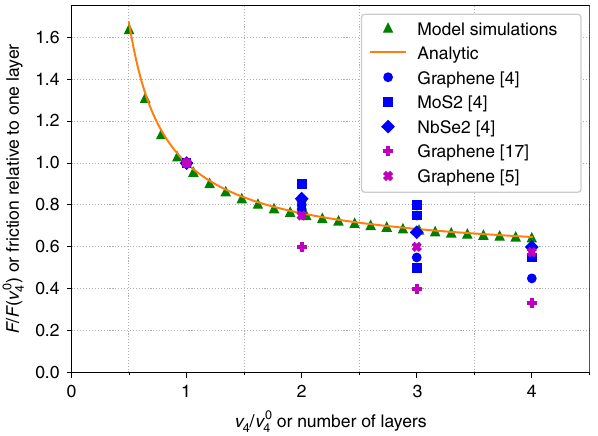
Fig. 3 The steady-state friction. The friction obtained numerically from our model with incommensurate lattice parameters (green triangles) along with the analytical estimation in Eq. (7) (orange line) and several literature results from experiments ( fi lled blue circles, squares, and diamonds) and detailed atomistic simulations (purple crosses). ν number of layers, n . Our standard value ν 4 ¼ 3 : 64 eV nm (cid:1) 4 ¼ ν 0 corresponds roughly to a single layer. All values are scaled by the friction on a single layer, and hence all points for ν 4 = ν 0